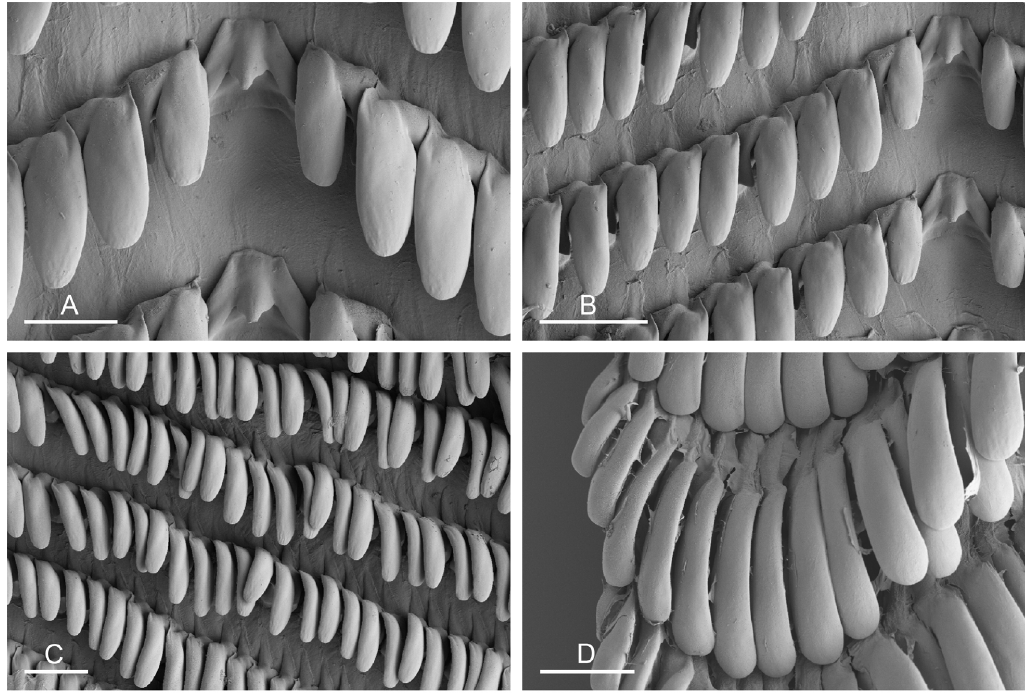
Fig. 36. Paromoionchis boholensis gen. et sp. nov., unit #2, radula, Indonesia, Ambon [2851] (UMIZ 00146). A . Rachidian and innermost lateral teeth. B . Lateral teeth with rachidian teeth. C . Lateral teeth. D . Outermost lateral teeth. Scales: A, D = 30 μm; B–C = 50